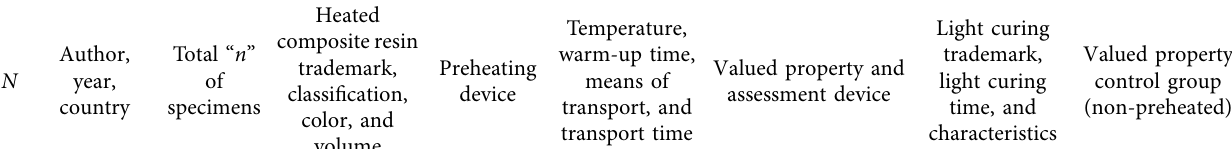
Table 2: Main characteristics of the included